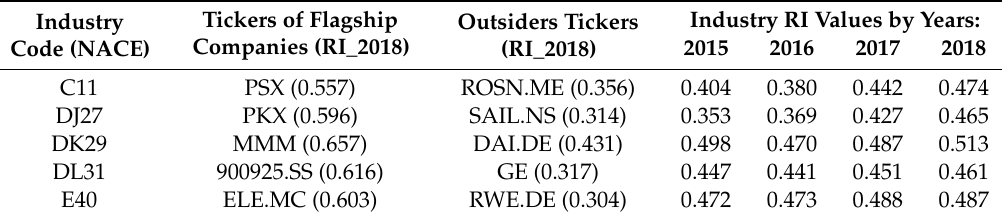
Table 5. Levels of sectoral economic